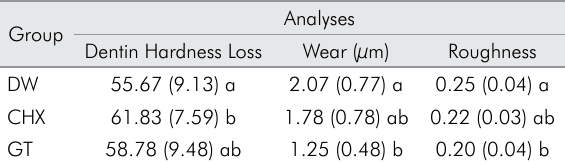
Table. Means and standard deviations of the loss of dentin hardness, wear and roughness values for all the treatments